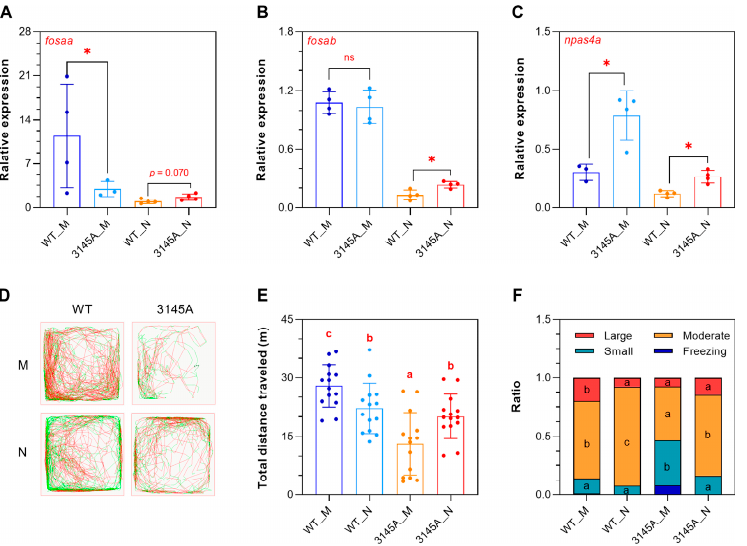
Figure 10. The prkcaa mutants are more active at night. ( A – C ) Expression of the representative circadian genes determined by qPCR. ( A ) fosaa , ( B ) fosab , (C) npas4a . ( D ) Representative tracked trajectories of the fish in the morning and at night. The red and green line segments represent large (>15 cm/s) and moderate (1–15 cm/s) movements, respectively. M, morning (9:00–11:00 a.m.); N, night (9:00–11:00 p.m.). ( E ) Total distance traveled. ( F ) Time ratio of the speed-based movement categories. The error bars represent standard error ( n = 14). Different letters overlaid on the bar segments indicate significant difference between the means (* p < 0.05).